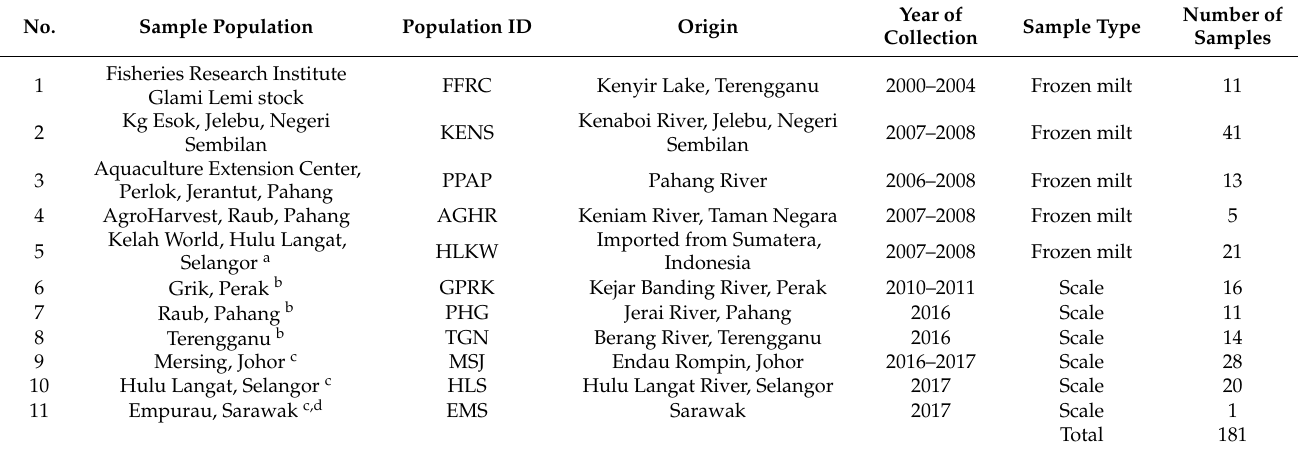
Table 1. The Malaysian mahseer samples used for microsatellite genotyping in this